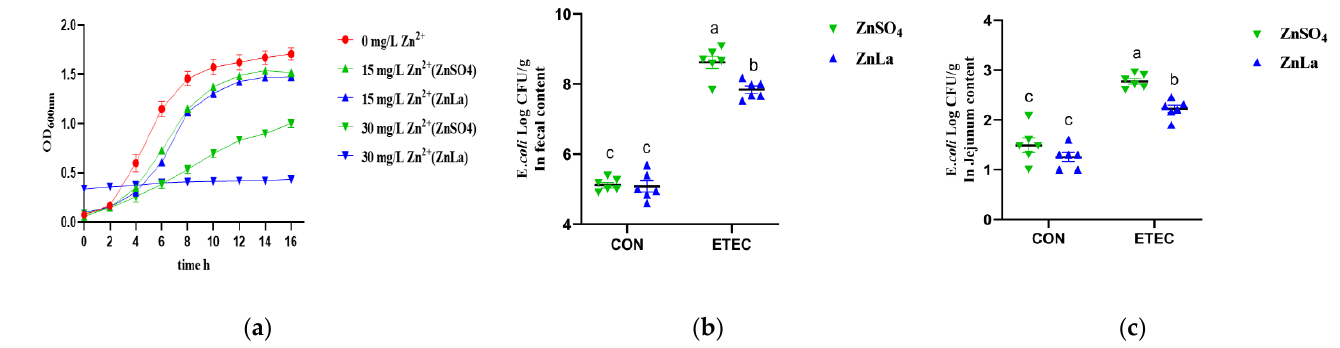
Figure 9. Effects of different zinc sources on the ETEC growth curve in vitro and ETEC shedding in mice. ( a ) ETEC growth curve and ( b , c ) content of ETEC in the feces and jejunum. The data are expressed as mean ± s.e.m (n = 6), and different lowercase letters in each group show significant differences ( p < 0.05).